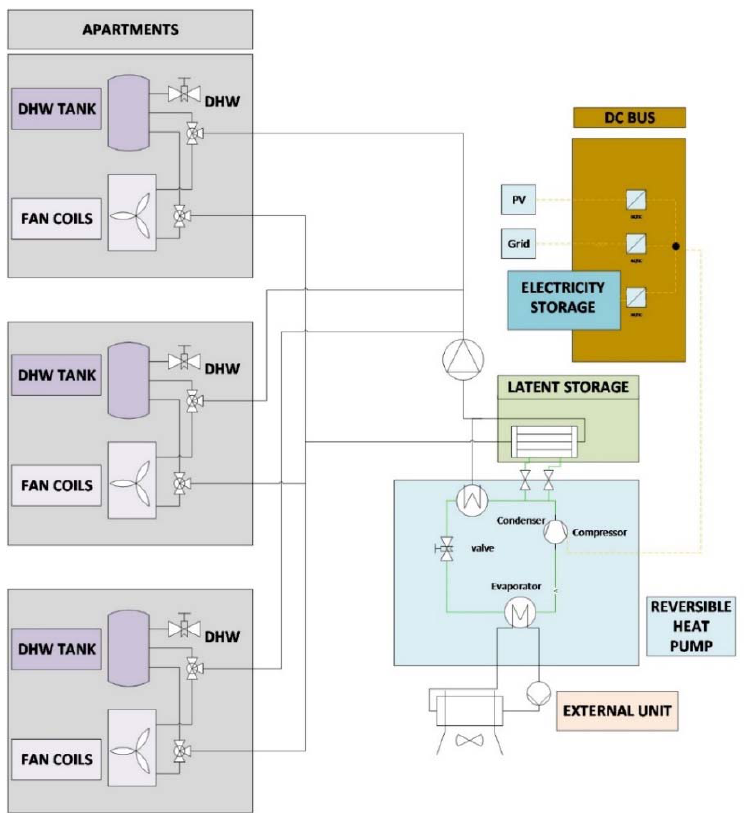
Figure 2. Schematic diagram for the innovative system.